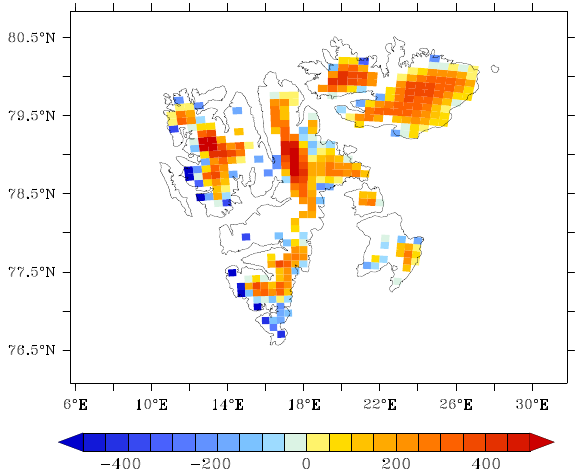
Figure 14. 1980–2005 mean annual SMB (mmw . e . yr − 1 ) modelled by MAR MIROC5